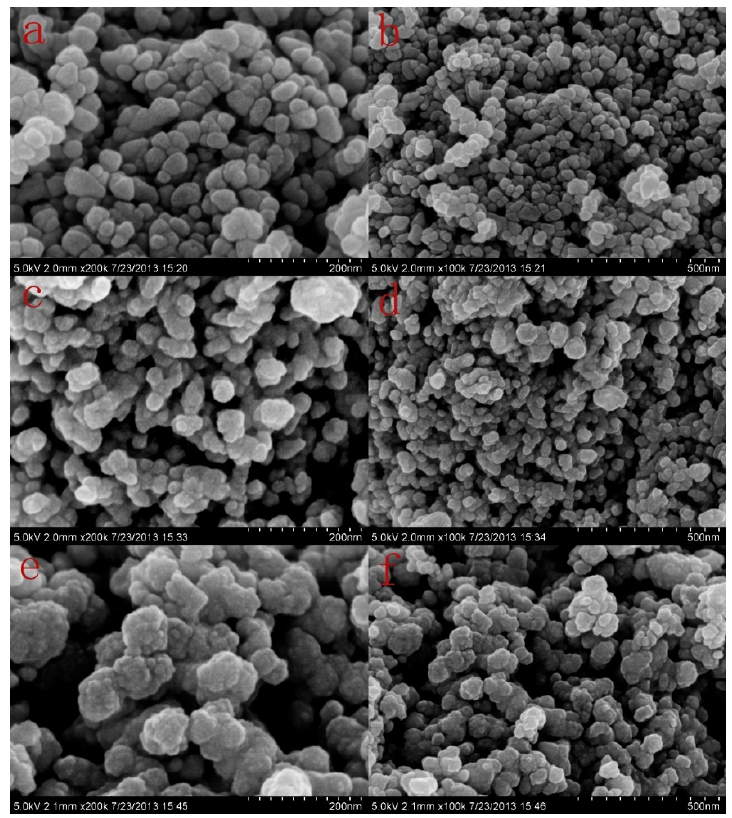
Figure 2. Scanning electron microscopy (SEM) images of ( a,b ) ZnO, ( c,d ) PDA/ZnO, and ( e,f ) DMSA/PDA/ZnO.